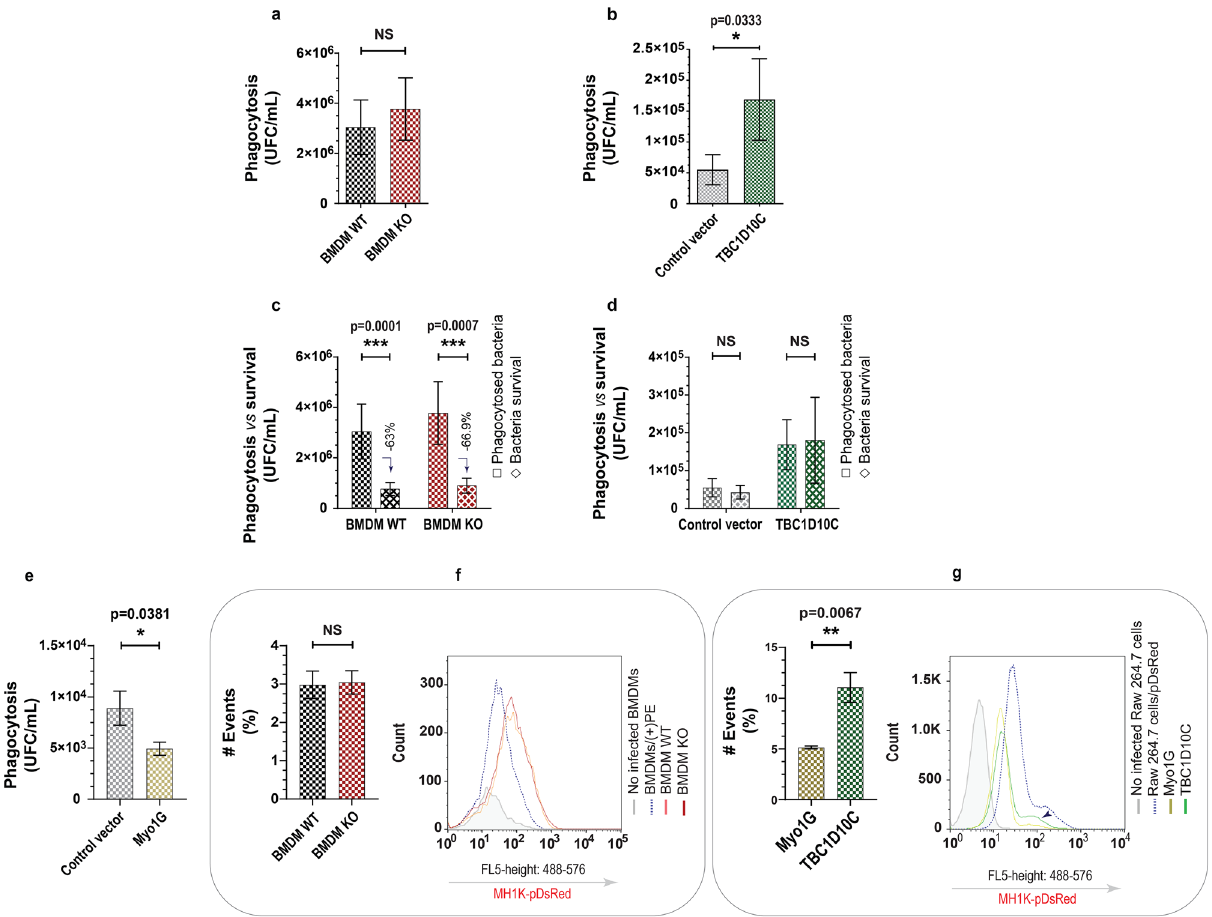
Figure 3. Evaluation of TBC1D10C’s effect on phagocytosis of Burkholderia cenocepacia . The effect of TBC1D10C elimination and overexpression on phagocytosis of B. cenocepacia was determined by CFU (colony forming unit) quantification in the gentamicine protection assay and flow cytometry at a MOI of 50 (multiplicity of infection). ( a ) Quantification of CFU (phagocytosed living bacteria at 1.5 h postinfection) in infected BMDMs (mice, n = 7); ( b ) quantification of CFU in infected Raw 264.7 transfected cells (control vector and TBC1D10C, respectively); ( c ) quantification of CFU in infected BMDMs at 5 h postinfection (comparison of phagocytosed, in ( a ) bacteria vs. bacteria survival); ( d ), quantification of CFU in infected Raw 264.7 transfected cells at 5 h-postinfection (control vector and TBC1D10C, respectively); ( e ) quantification of CFU in infected Raw 264.7 transfected cells (control vector and Myo1G; unrelated protein to TBC1D10C, respectively); ( f ) left: data of quantified events expressed as a percentage of BMDMs infected with transformed B. cenocepacia (MH1K-pDsRed) by flow cytometry, right, representative histogram of 2 independent experiments for ( f ) (BMDM/( +)PE is positive control for infection: MH1K-pDsRed); ( g ) left: data for quantified events expressed as a percentage of Raw 264.7 transfected macrophages infected with transformed B. cenocepacia (MH1K-pDsRed) by flow cytometry, right, representative histogram of 2 independent experiments for ( g ) (Raw 264.7 cells/ pDsRed is positive control for infection; cells highly infected). Data were analyzed by the Mann–Whitney test (P < 0.05), and graphs show etry to more directly analyze the uptake of B. cenocepacia . With this analysis, we confirmed that elimination of TBC1D10C did not correlate with important changes in phagocytosis for B. cenocepacia (Fig. 3f), whereas TBC1D10C overexpression did so (Fig. 3g). Our results indicate that TBC1D10C contributes to the internaliza- tion of B. cenocepacia by RAW 264.7 macrophages. TBC1D10C is a protein intimately associated with cytoskeleton‑plasma membrane reorgani‑ zation and tension. Cell spreading and phagocytosis are related cellular processes that notably require cytoskeleton-plasma membrane reorganization as well as the participation of multiple proteins 28,33,34 ; our data indicate that TBC1D10C participates in such cellular functions. To better understand the mechanistic contribu- tion of TBC1D10C to cell spreading and phagocytosis, we carried out proteomic analysis using stably transfected RAW 264.7 cells (GFP tag-TBC1D10C). TBC1D10C was immunoprecipitated to identify proteins in the com- plex by mass spectrometry followed by bioinformatics analysis. This led us to identify 27 TBC1D10C-interacting proteins (Table 1), which were functionally grouped in cytoskeleton organization, protein localization to orga-